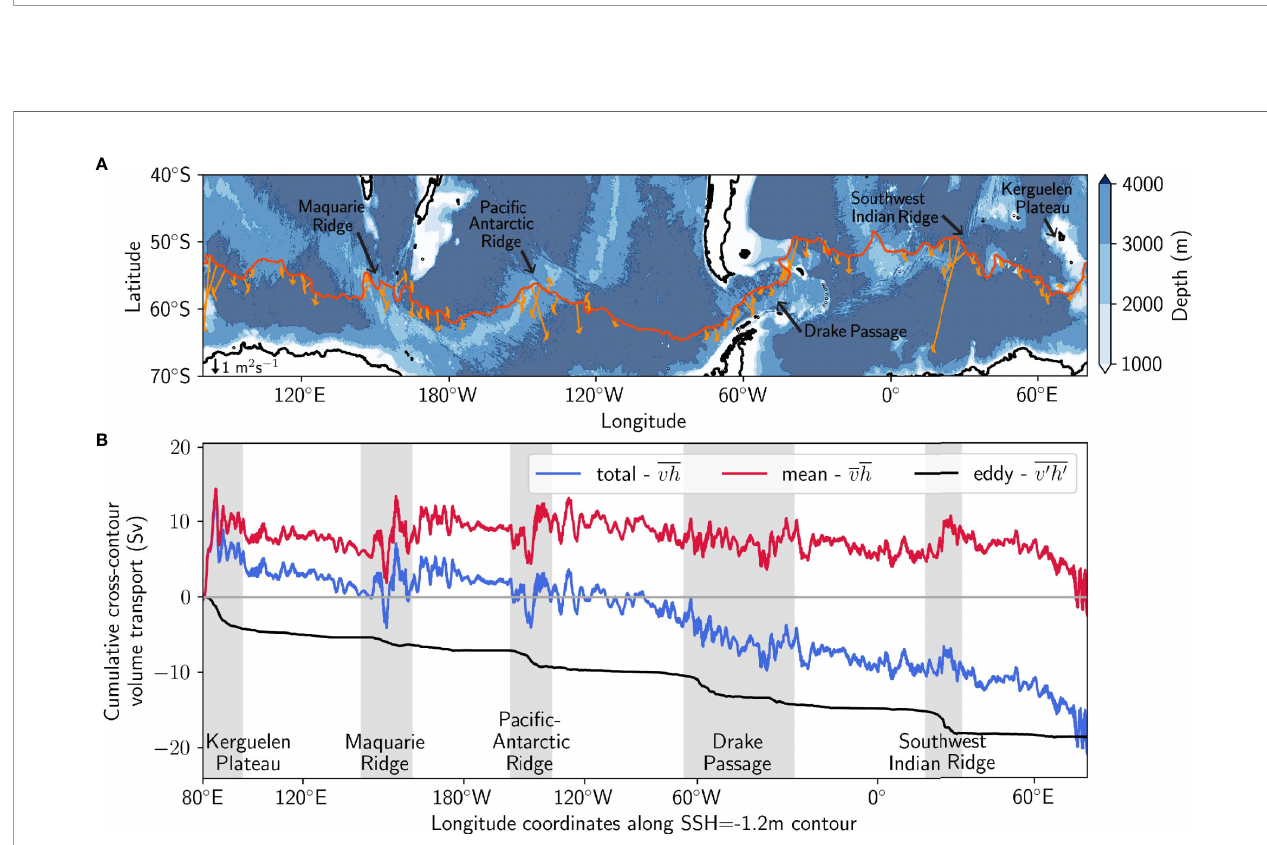
FIGURE 7 | (A) Eddy transport t eddy ( r , x , C ) integrated over the upwelling arm of the ocean, illustrated by arrows every 5° on the -1.2 m SSH contour, which show the direction and size of cross-contour eddy transport (an arrow is shown for scale in the bottom left corner). Transports with magnitude less than 0.2 m 2 s -1 are not shown. Background shows bathymetry. (B) Cumulative integrals from west to east along the SSH contour of total, mean and eddy cross-contour volume transport, for the -1.2 m SSH contour. Transports are vertically integrated over the density range of the upwelling arm. Grey bars highlight the eddy upwelling